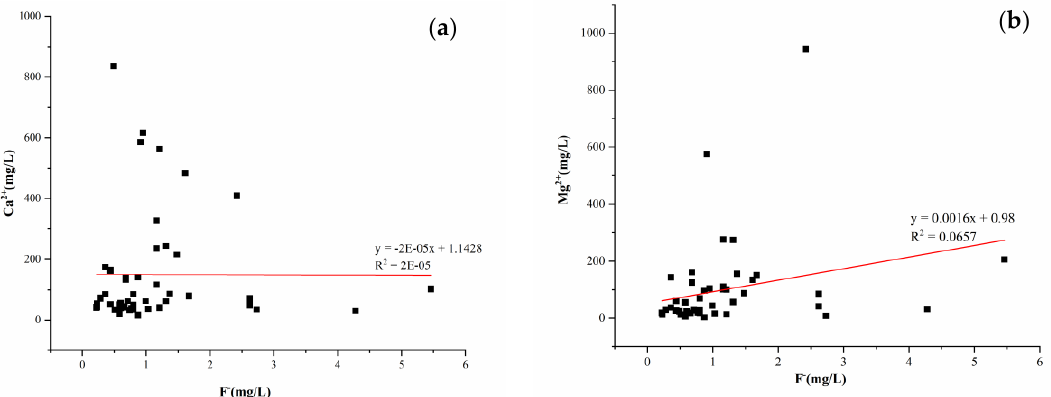
Figure 4. Relationship between the F − mass concentration and the Ca 2+ ( a ) and Mg 2+ ( b ) mass concentrations in the groundwater samples.